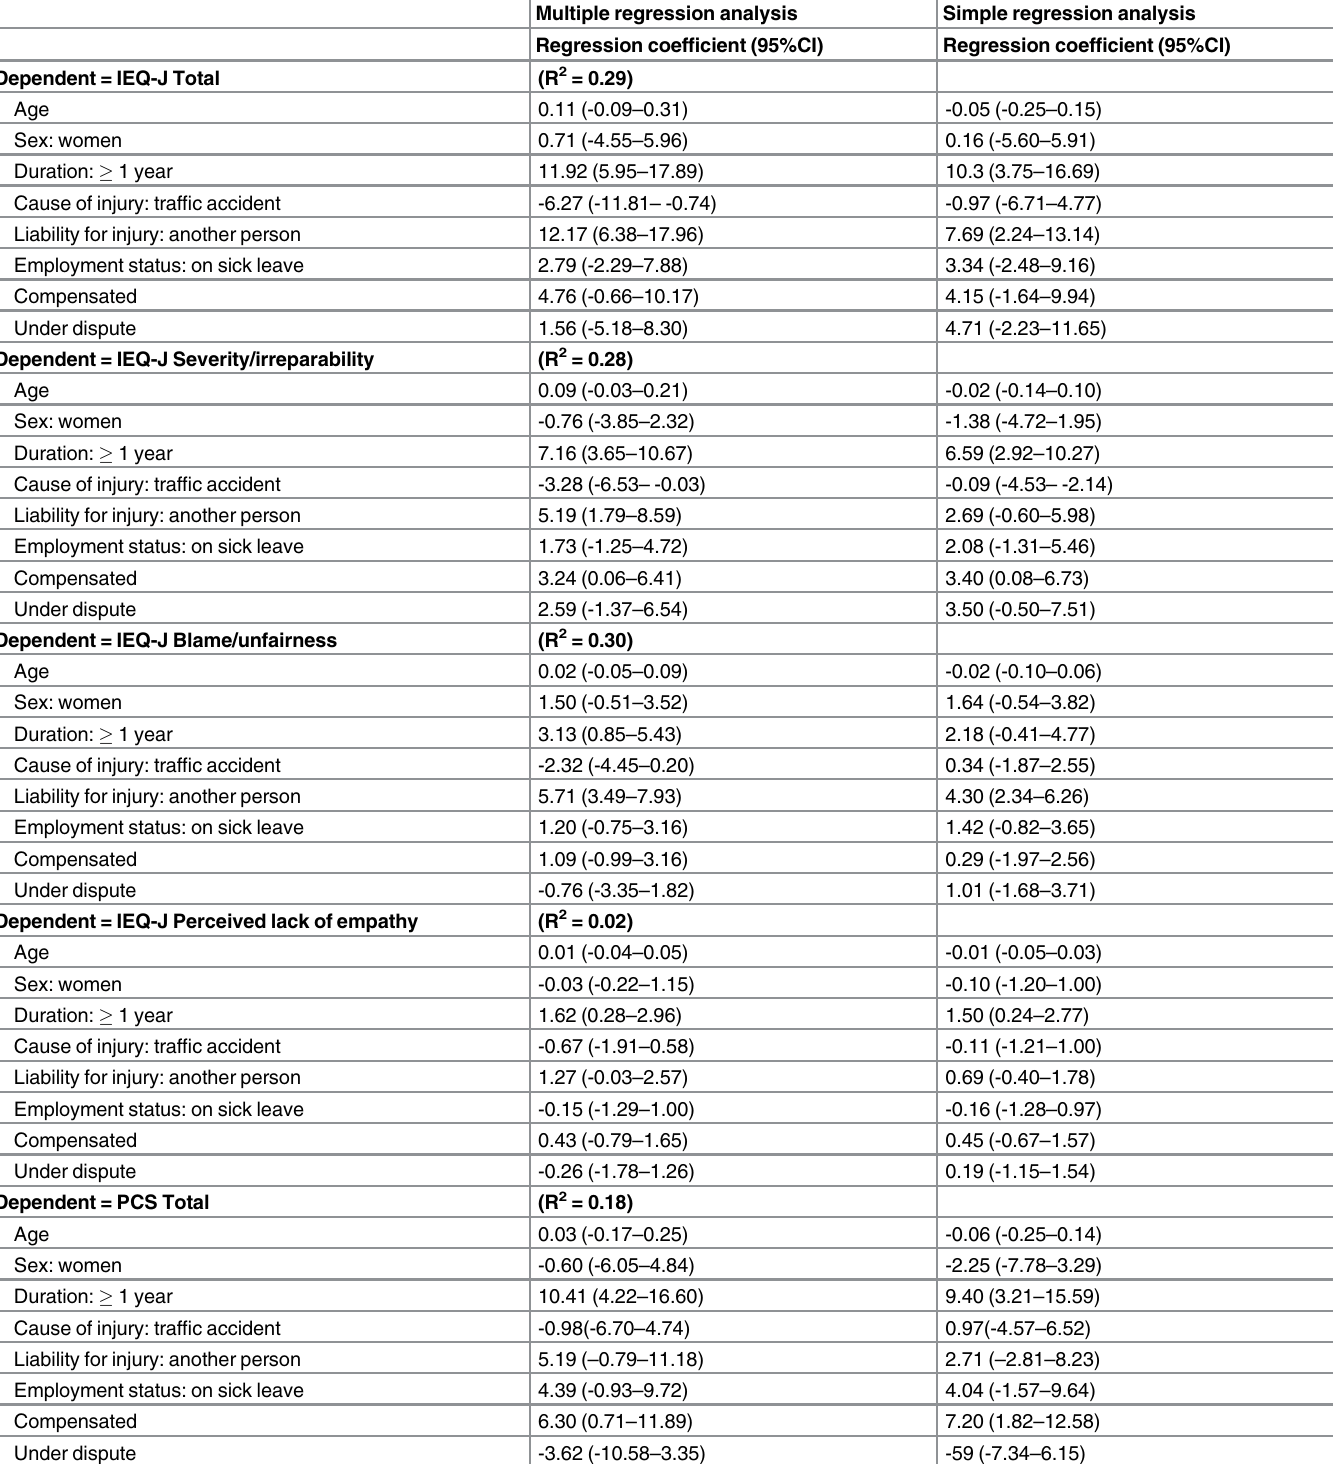
Table 8. Multiple or simple regression analysis examining associations between sample characteristics and perceived injustice or pain